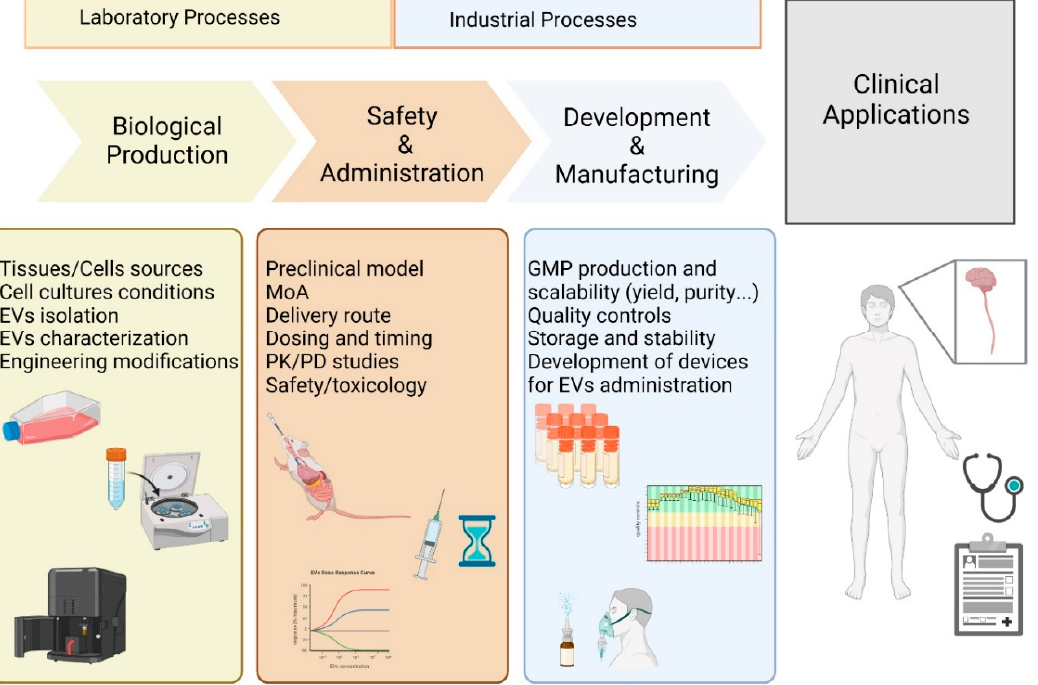
Figure 3. From bench to clinic application of MSC-EVs. Representative overview of the translational development of MSC-EV-based therapies. The use of MSC-EVs in clinical applications requires several key steps: the downstream biological aspects followed by administration and safety studies until the GMP production and regulatory aspects reflect the linear progression from bench to clinic. MoA = mode of action; PK = pharmacokinetic; PD = pharmacodynamic; GMP = good manufacturing practices.